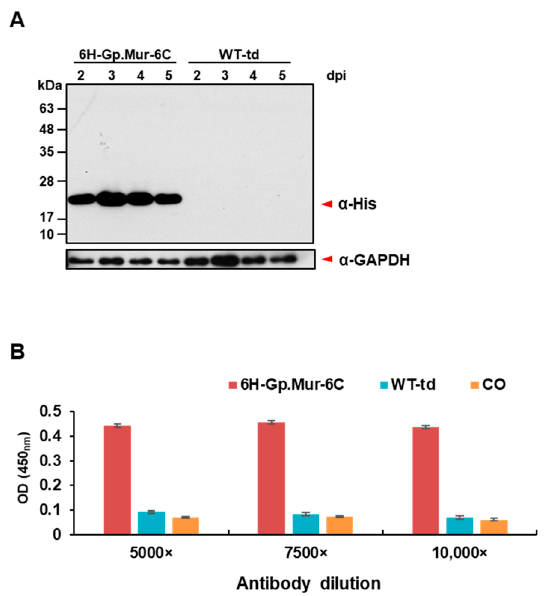
Figure 2. Cell surface expression of the Gp.Mur construct. ( A ) Protein expression levels of recom- binant baculovirus v6H-Gp.Mur-6C-infected Hi5 cells at different time points by Western analysis. ( B ) Protein expression levels of Gp.Mur recombinant baculovirus v6H-Gp.Mur-6C-infected Hi5 cells using cell-based ELISA. Primary antibody used in Western analysis is mouse anti-His antibody ( α -His, 1:5000), for internal control, rabbit anti-GAPDH, ( α -GAPDH, 1:5000) was used; primary antibody used in cell-based ELISA is anti-His antibody at different dilutions. DPI: days post infection; WT-td: WT-td-infected Hi5 cells; CO: cell only (uninfected cells).